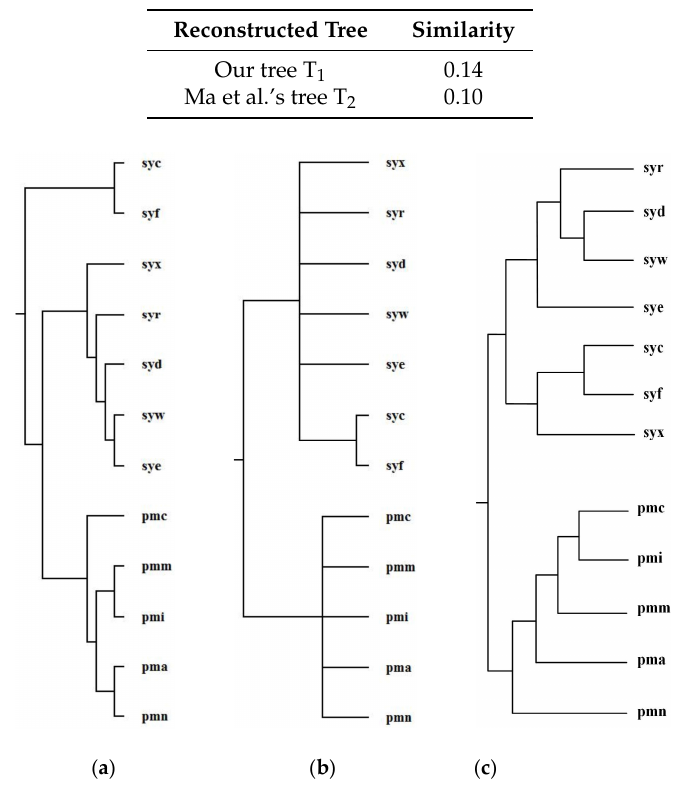
Table 3. Similarity of reconstructed tree to the NCBI taxonomy T for the organisms in Figure 8.